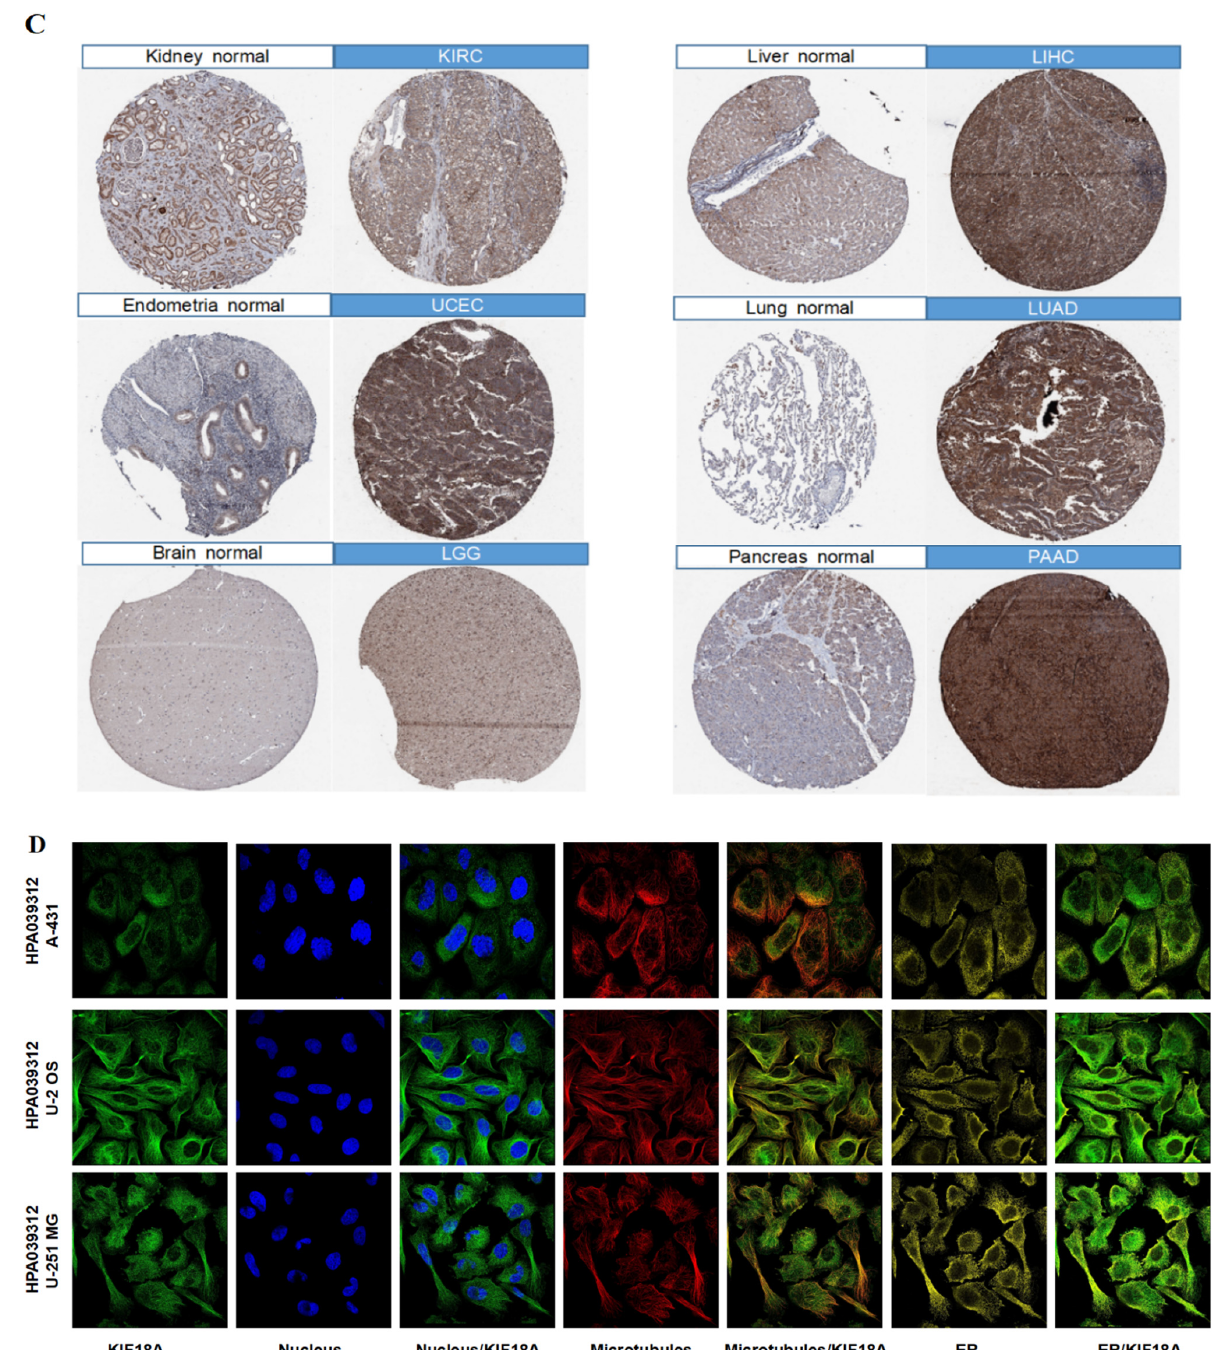
Figure 1. KIF18A expression in pan-cancer from different databases. ( A ) KIF18A expression in pan- cancer in TIMER. ( B ) KIF18A expression in cancers in TCGA + GTEx. ( C ) KIF18A expression in KIRC, LIHC, UCEC, LUAD, LGG, and PAAD from the HPA database. ( D ) Immunofluorescence staining of the subcellular localization of KIF18A in HPA database. (*, p < 0.05; **, p < 0.01; ***, p < 0.001, ns: no statistical differences).